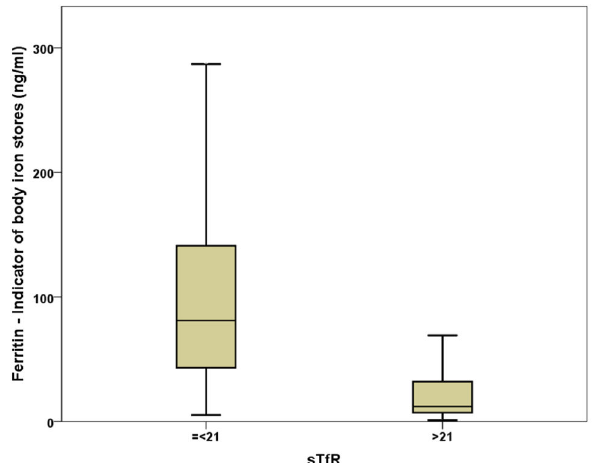
Figure 1. Distribution of ferritin in subjects with normal sTfR (=<21nmol/L) and those with elevated sTfR (>21nmol/